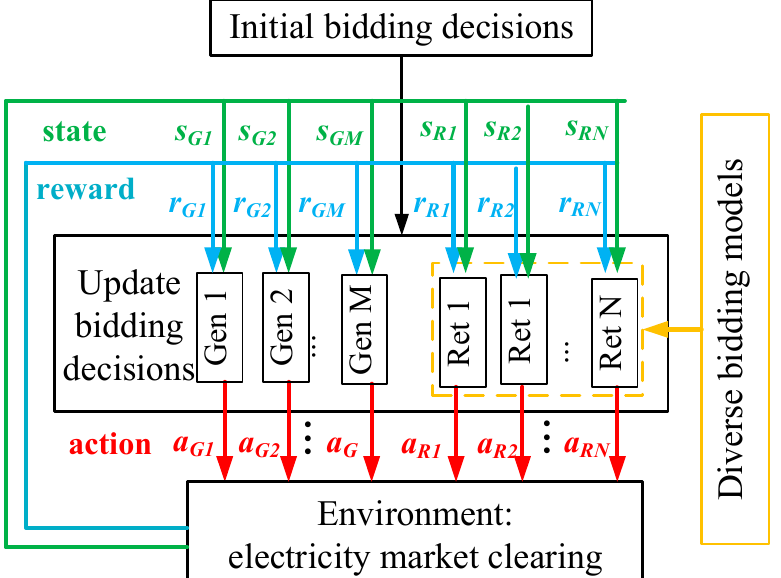
Figure 5. Electricity market simulation model based on reinforcement learning.